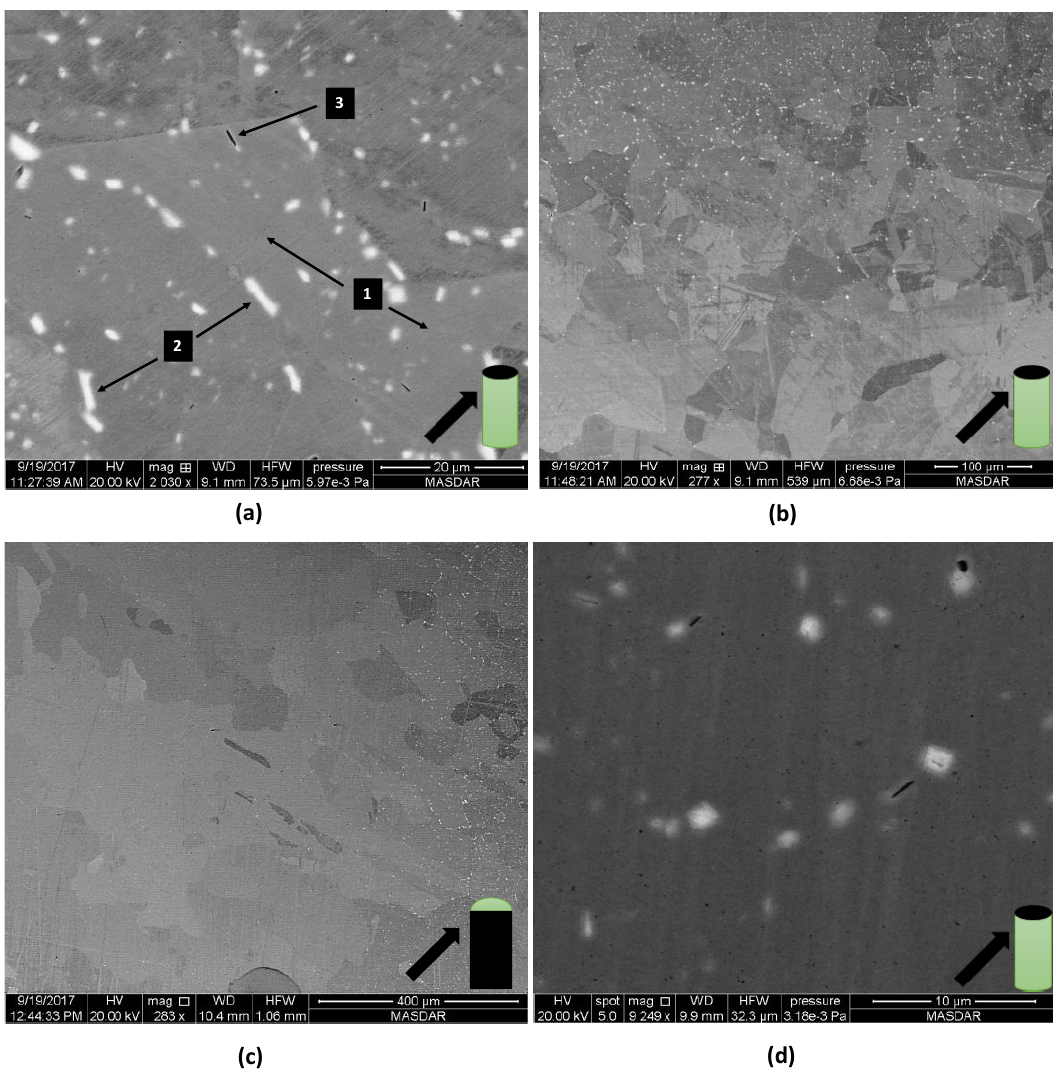
Figure 7. ( a ) SEM image of the 𝛾 matrix, MC-carbide precipitate, and δ precipitate phases in the HIP specimen labeled 1, 2, and 3, respectively; ( b ) SEM image of dense regions of carbide phases along the edge (located at the top of the image) of the horizontal cross-section of the HIP specimen and their rapid dispersal away from the edges; ( c ) SEM image of dense regions of carbide phases along the edge (located at the right side of the image) of the vertical cross-section of the HIP specimen and their rapid dispersal away from the edges; ( d ) High-magnification SEM image showing the disappearance of the Laves phase and 𝛾 ′′ .